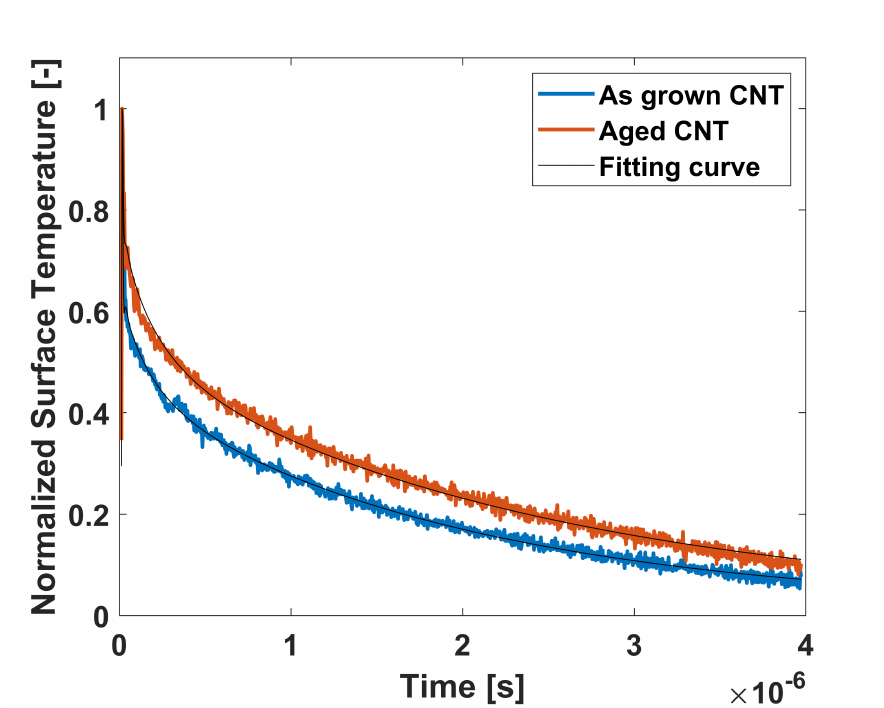
Figure 7. Time–temp response curve from PPR measurements on samples before and after thermal aging together with the numerical fitting